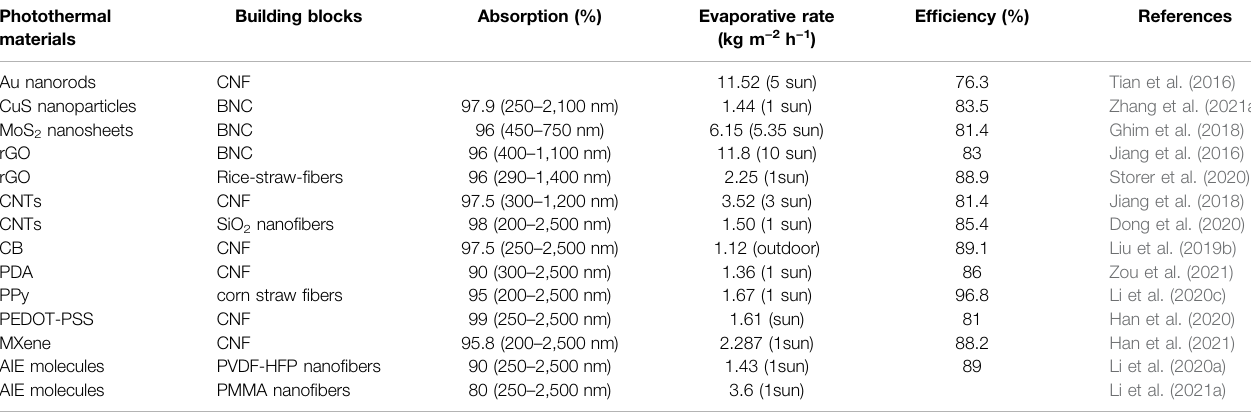
TABLE 1 | SVG performances of different photothermal materials and fi brous building blocks. Photothermal